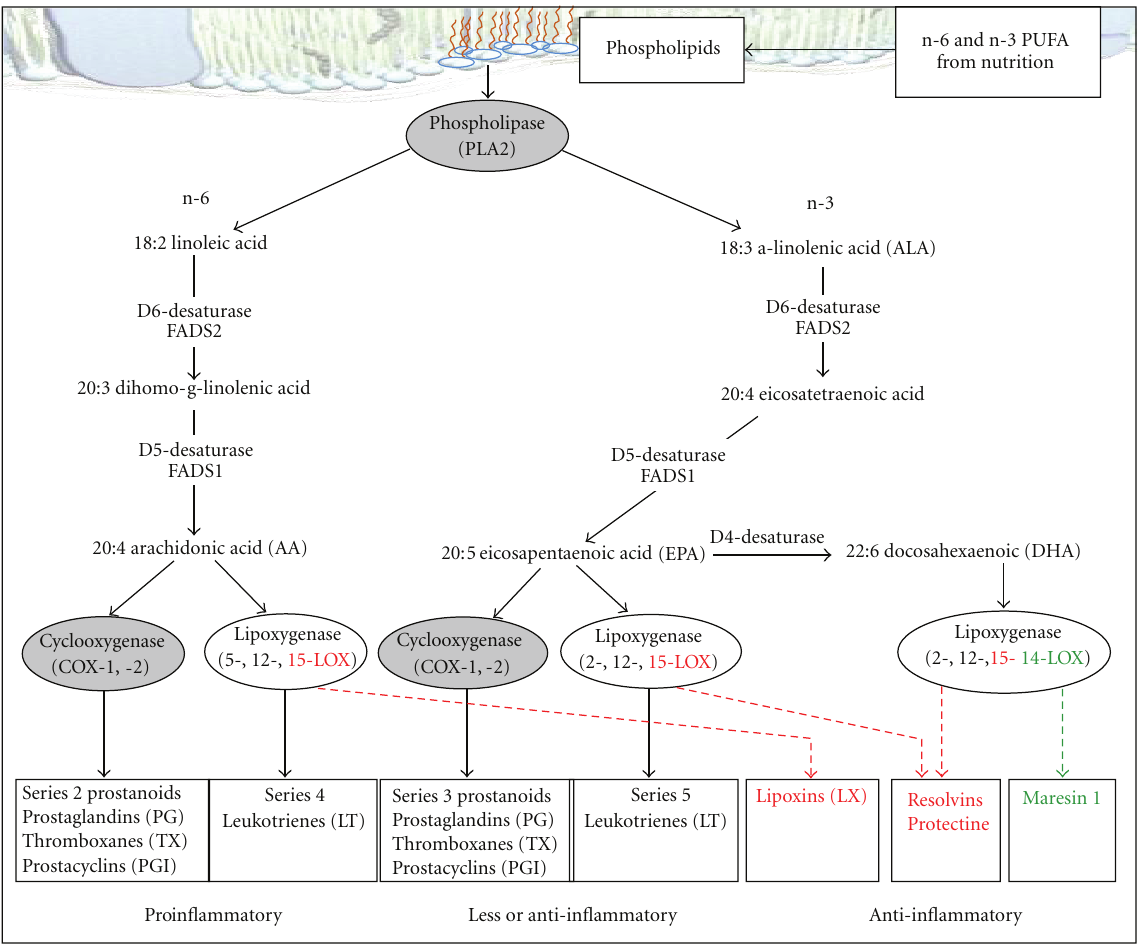
Figure 3: Metabolism of polyunsaturated fatty acids and their signaling molecules. Adapted from [41–43]. The 3D plasma layer image was modified from the one provided by M´elanie Villeneuve, La cellule animale, CCDMD, 2008 (http://www.ccdmd.qc.ca/ri/cellule/index.php?nh = 18).